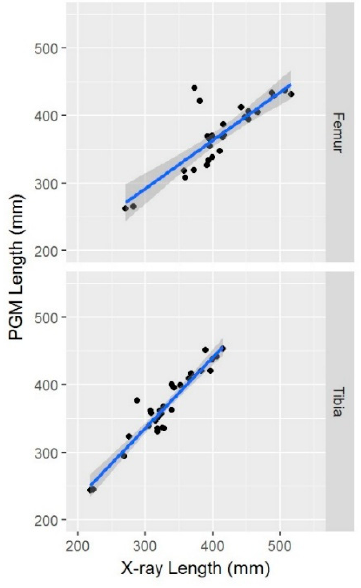
Figure 2. Correlations between femur and tibia PGM and X-ray segmental length.